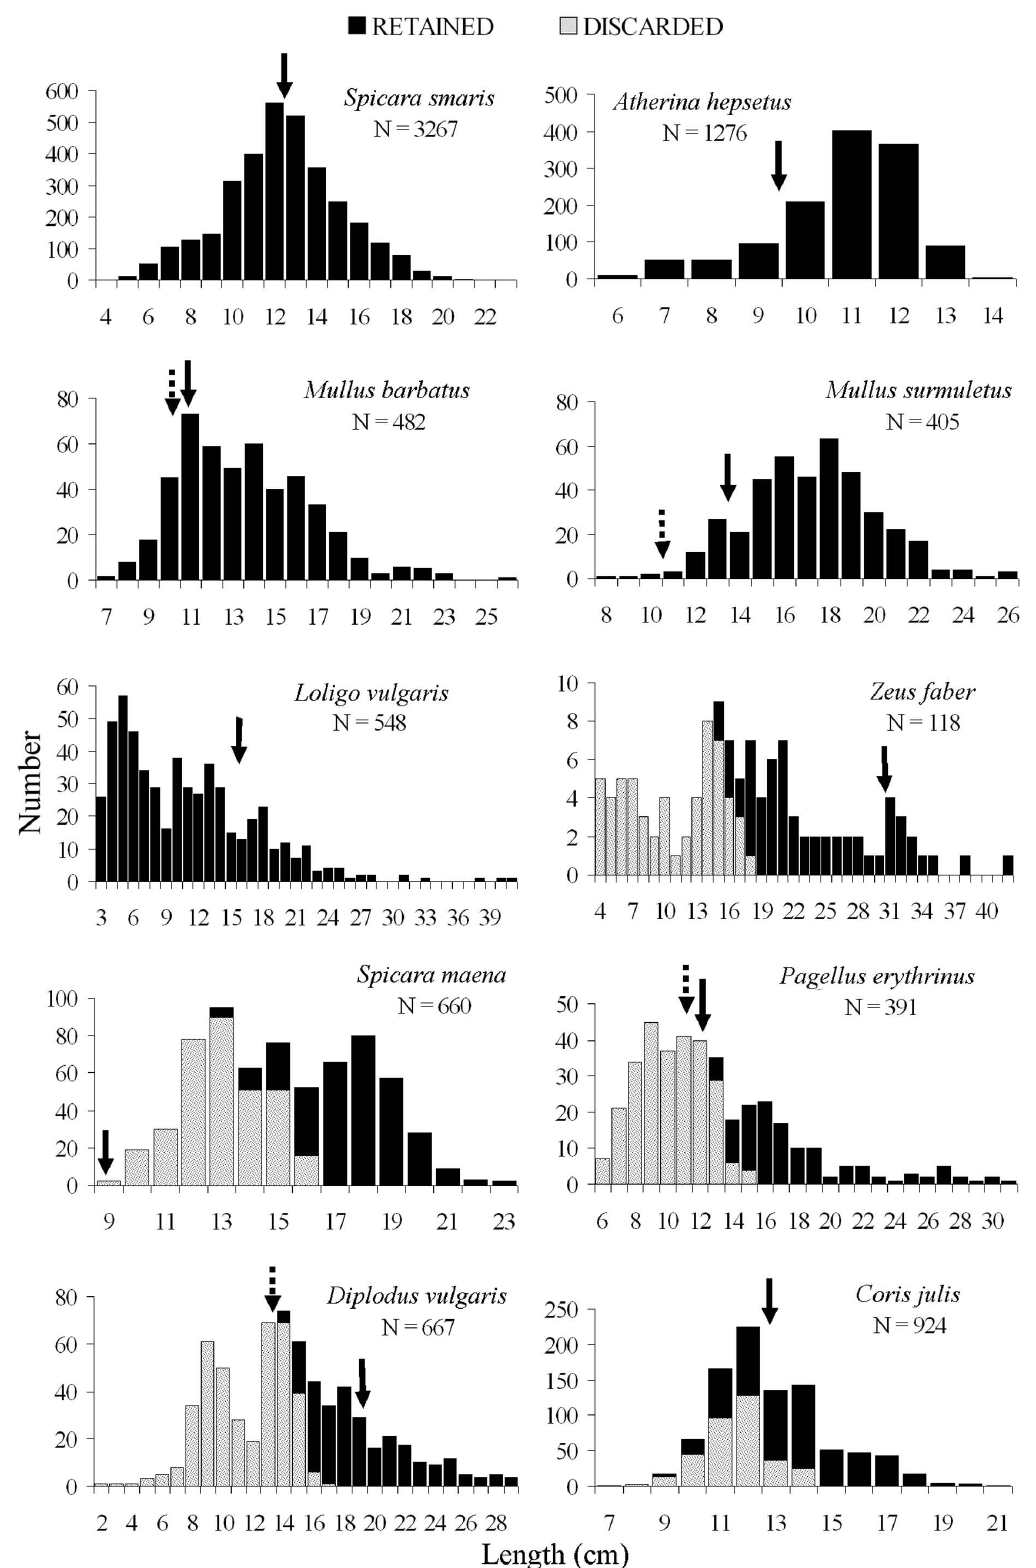
Fig . 5. – Length-frequency distributions of retained and discarded catches of the most important species. Solid arrows denote length at first maturity taken from the literature, dotted arrows indicate minimum landing size (MLS) when